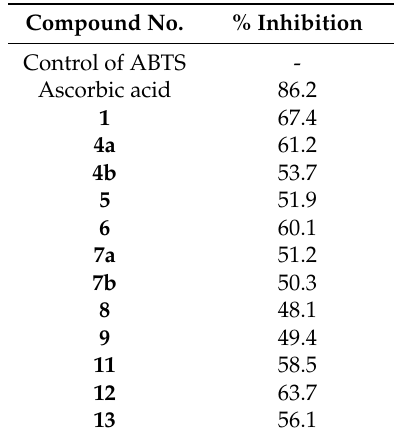
Table 1. Antioxidant activity assay (ABTS) of the tested compounds. Compound No. %